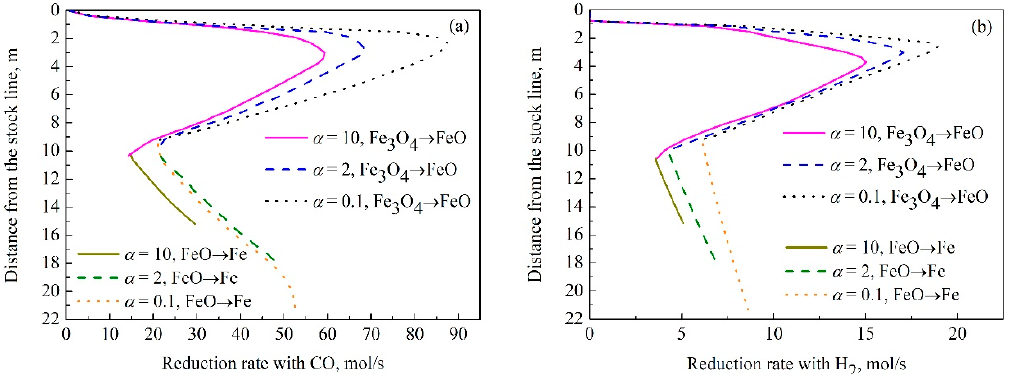
Figure 6. Distributions of reduction rate with CO ( a ) and H 2 ( b ) under di ff erent coke reactivity in indirect reduction region.